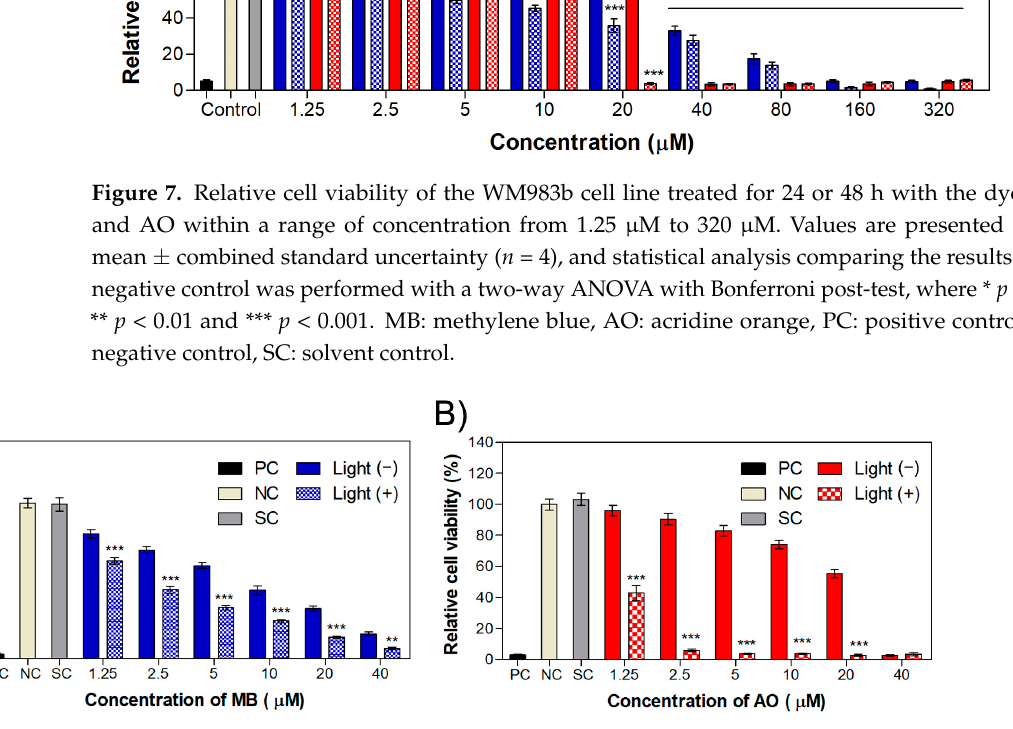
Figure 8. Relative cell population of the WM983b cell line treated for 24 h with dye molecules ( A ) MB and ( B ) AO and submitted to irradiation. Samples not treated with irradiated light ( − ) were used as controls for comparison with those submitted to irradiation at different light wavelengths (640 nm for MB and 457 nm for AO). The light dose applied to the irradiated cells was 2.5 J/cm². Values are presented as means ± combined standard uncertainty ( n = 6), and statistical analysis was performed with a two-way ANOVA with Bonferroni post test, where ** p < 0.01 and *** p < 0.001, in comparison with the dark control. MB: methylene blue, AO: acridine orange, PC: positive control, NC: negative control, SC: solvent control.